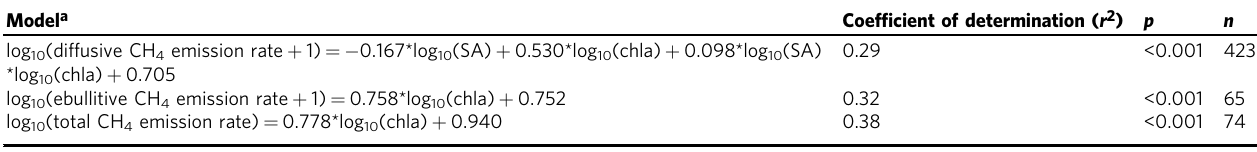
Table 3 Statistical models used to predict methane (CH 4 ) emission rates Model